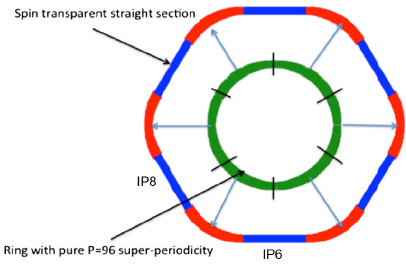
FIG. 1. Projecting the pure ring lattice with 96 periodicity onto the RHIC six fold periodic ring.